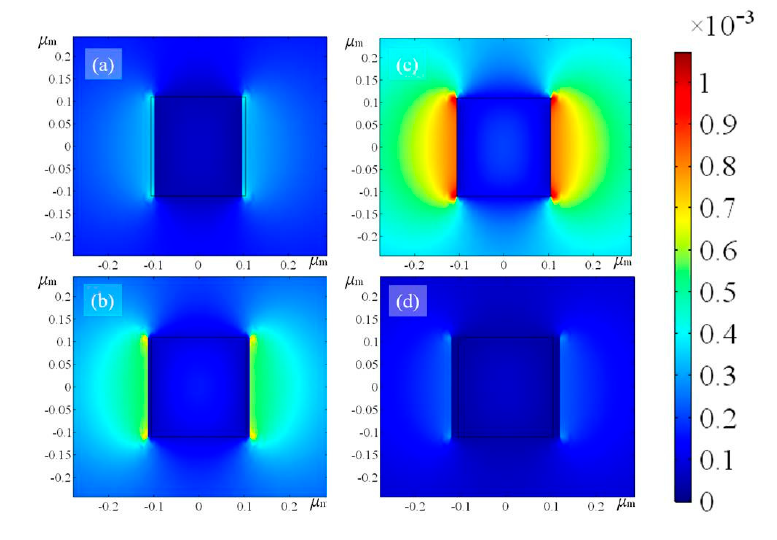
Figure 1. COMSOL eigenmode analysis showing the normalized electric field x-component of TE- mode for waveguide widths of ( a ) 195 nm, ( b ) 210 nm, ( c ) 225 nm, and ( d ) 240 nm at a constant waveguide height of 220